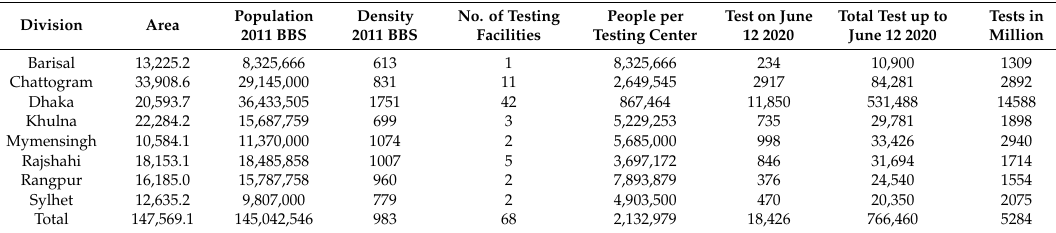
Table 2. Population density and testing facilities of COVID-19.